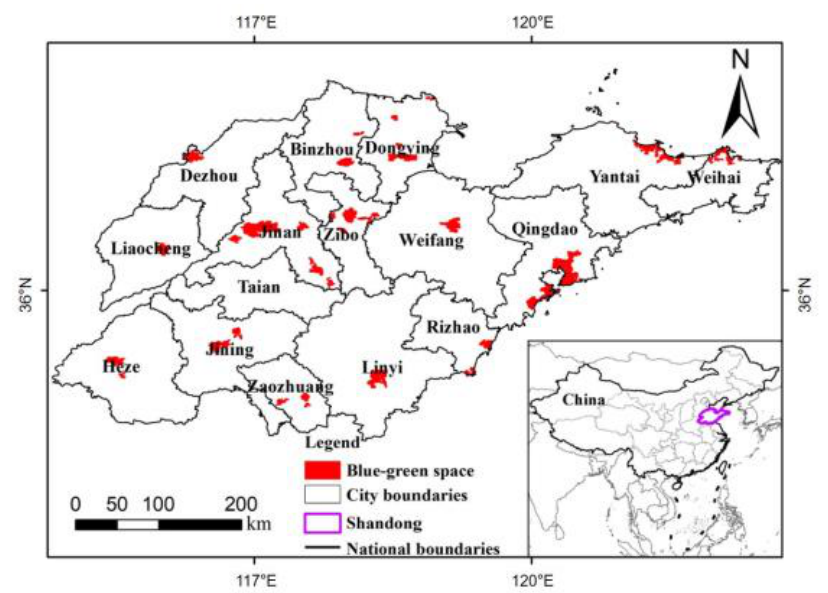
Figure 1. The study area of Shandong province, China.